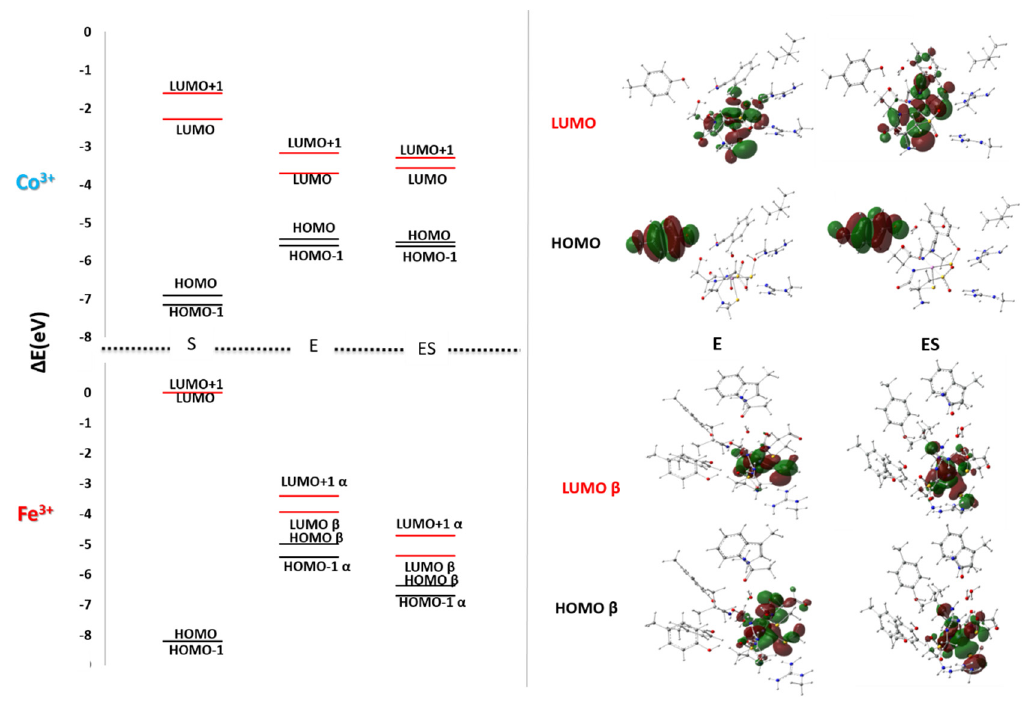
Figure 7. On the left, the energy displacement of frontier molecular orbitals of nitriles (S), apo-enzymes (E), and enzyme-substrate complexes (ES), with their relative representation, on the right.